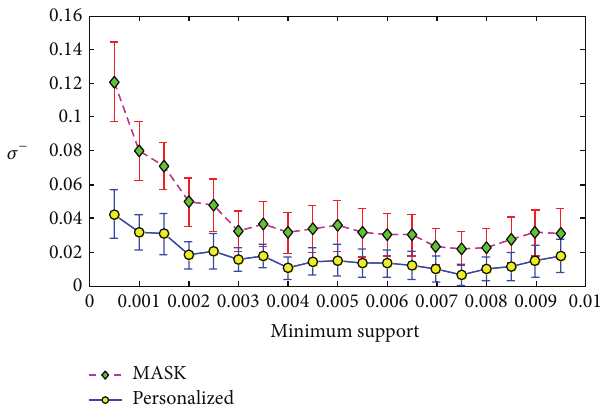
Figure 6: Frequent itemset lost ration 𝜎 − versus minimum support on T3.I4.D500K.N10.